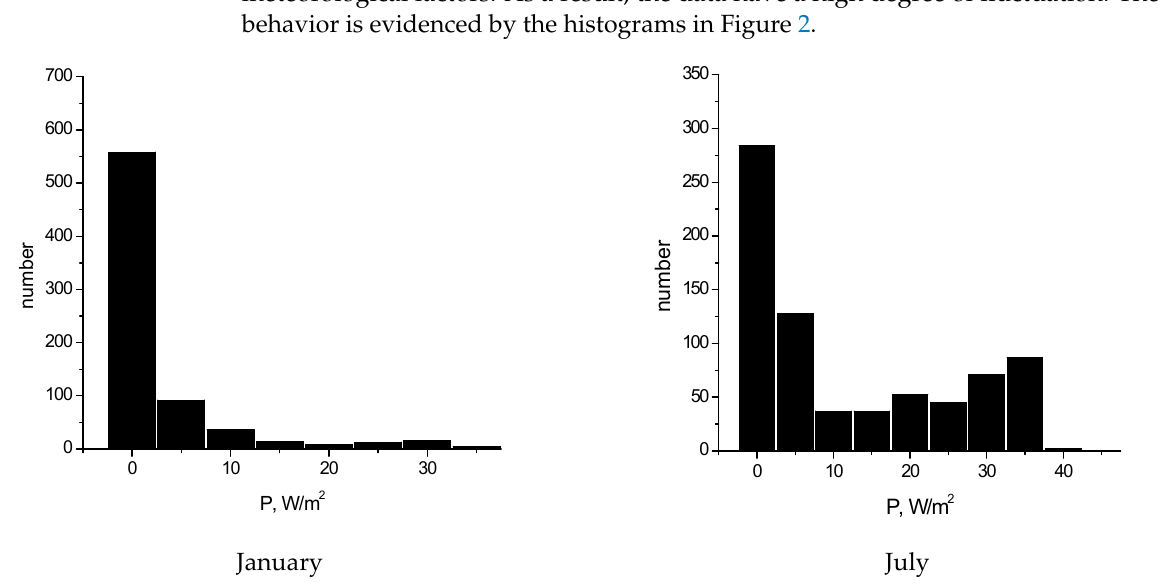
Figure 2. Histograms of specific power distribution data during January and July.